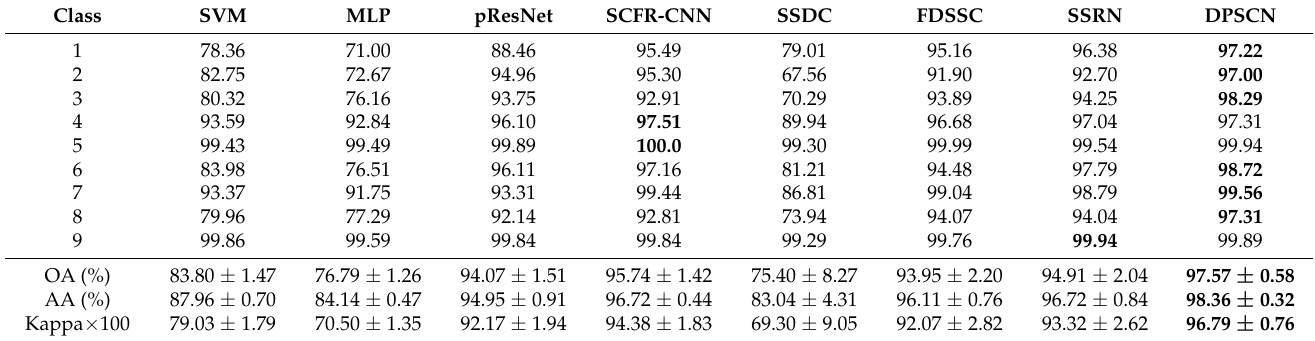
Table 7. Classification results of the different models for the PU data